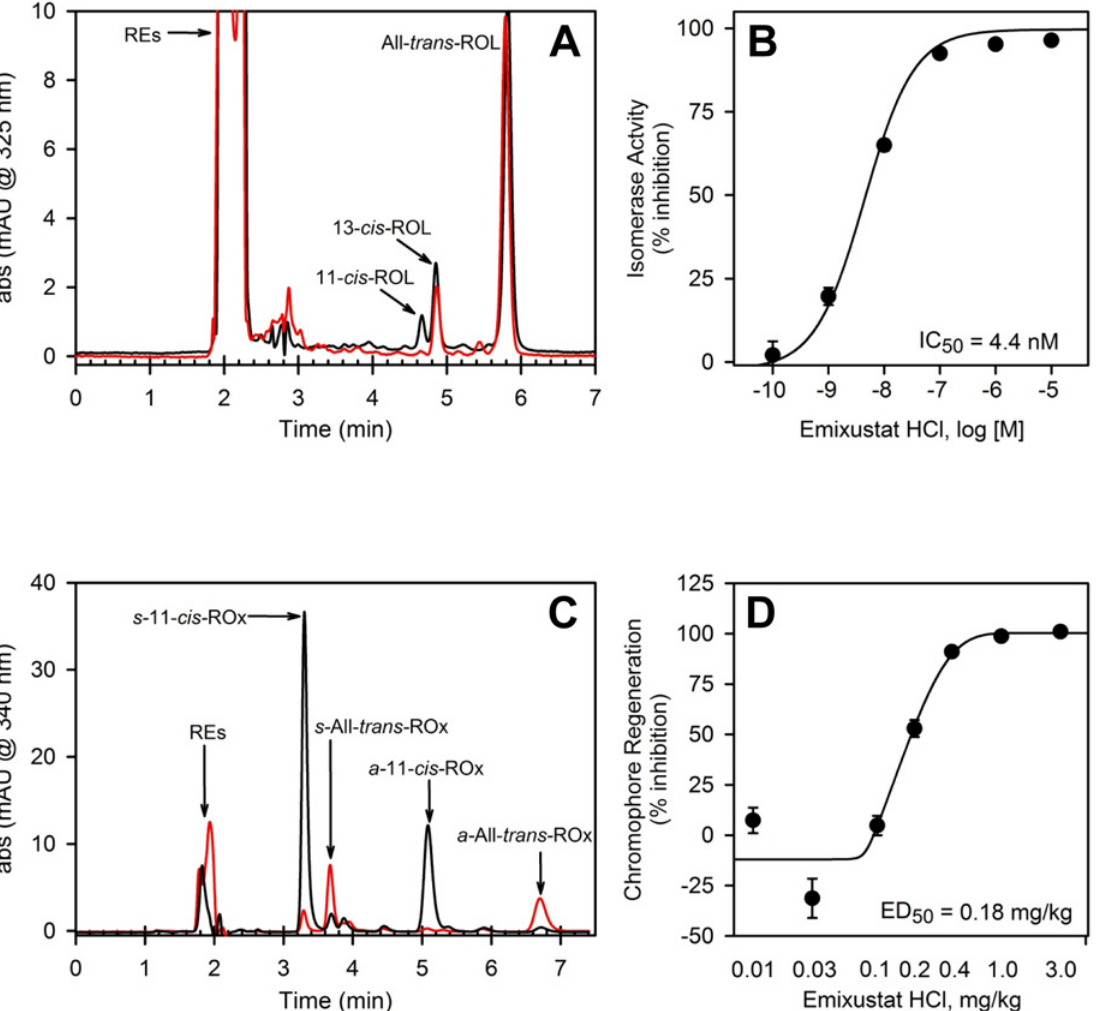
Fig 2. Inhibition of Isomerase Activity and Visual Chromophore Regeneration. The effect of emixustat on isomerase activity and visual chromophore regeneration was evaluated in in vitro and in vivo assays. Reaction conditions for in vitro assays are described in Methods . Retinoids in the sample extracts were measured by HPLC (RE, retinyl esters; ROL, retinols). Panel A shows representative HPLC chromatographic tracings from a control sample containing no emixustat (black trace) and a sample containing 1 μ M emixustat (red trace). Note absence of the 11- cis -ROL peak in the sample containing emixustat. The dose-response curve for inhibition of 11- cis -ROL production by emixustat is provided in panel B (each data point represents mean ± SEM, n = 8). The mean 11- cis -ROL level in control samples (no emixustat) was taken as 0% inhibition; half maximal inhibitory concentration (IC 50 ) for 11- cis -ROL production in the presence of emixustat is provided in the panel B inset. The effect of emixustat on visual chromophore regeneration in vivo was evaluated in wild-type mice as described in Methods . In these analyses, the amount of 11- cis -retinal production, at 2 hours in darkness following a photobleach (measured by HPLC as syn- and anti -11- cis -retinal oximes, s -11- cis -ROx and a -11- cis -ROx, respectively), in mice treated with varied doses of emixustat was examined. Sample chromatographic tracings of the retinoid profile from a vehicle-treated mouse (black trace) and a mouse treated with 1 mg/kg emixustat (red trace) are shown in panel C ( syn- and anti -All- trans -retinal oximes, s -All- trans -ROx and a -All- trans -ROx, and all- trans -retinyl esters, REs, are also shown). Note reduced level of syn- and anti -11- cis -retinal oxime peaks and increased REs in the trace from the emixustat-treated mouse. The dose-response curve for inhibition of visual chromophore production by emixustat is provided in panel D (each data point represents mean ± SEM, n = 8). The mean 11- cis -retinal oxime level in control samples (no emixustat) was taken as 0% inhibition. The calculated half maximal effective dose (ED 50 ) for inhibition of visual chromophore production by emixustat is provided in the panel D